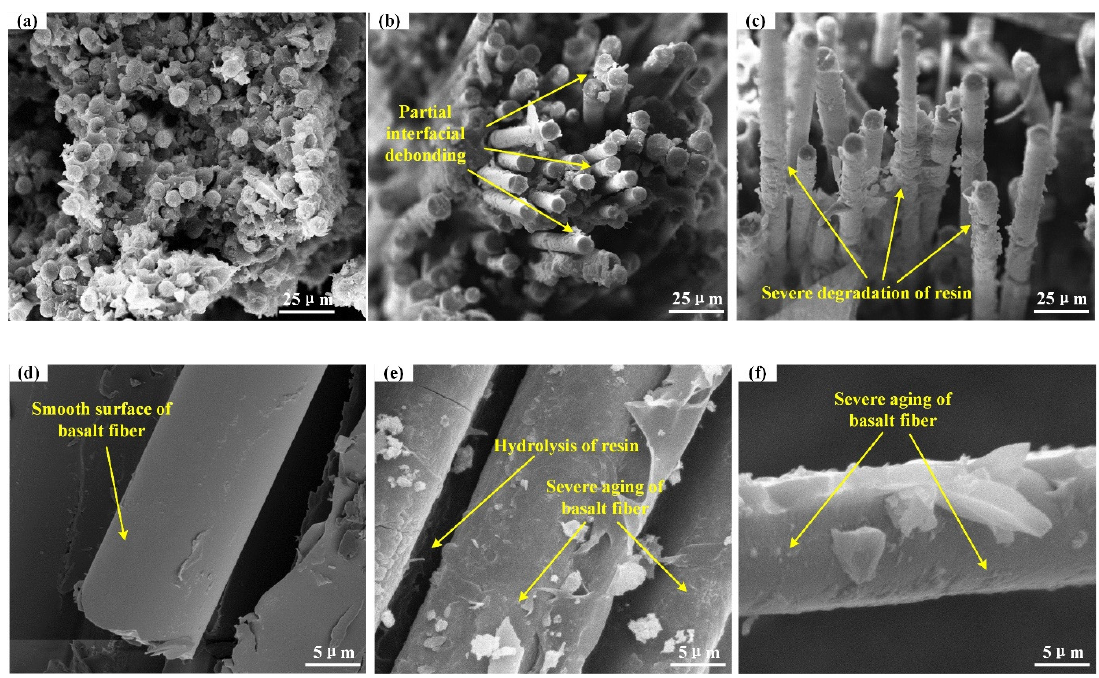
Figure 8. SEM images of tensile failure surfaces: ( a ) unaged specimen; aged specimen soaked in 60 °C alkaline solution last ( b ) 14 days and ( c ) 180 days; ( d ) unaged basalt fiber; aged basalt fiber soaked in 60 °C ( e ) deionized water and ( f ) alkaline solution last 180 days.